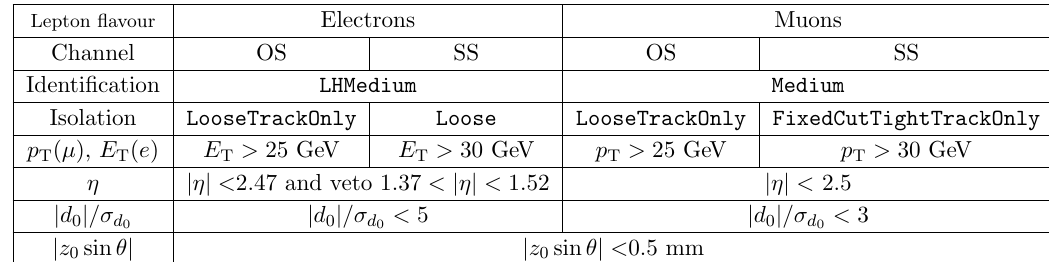
Table 1 . Object reconstruction selection in the OS and the SS channels. The requirements cor- responding to the identi(cid:12)cation and isolation working points are described in ref. [53] under the same